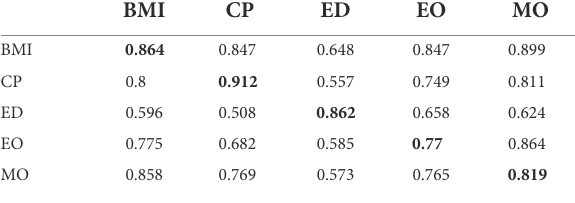
TABLE 3 Discriminant